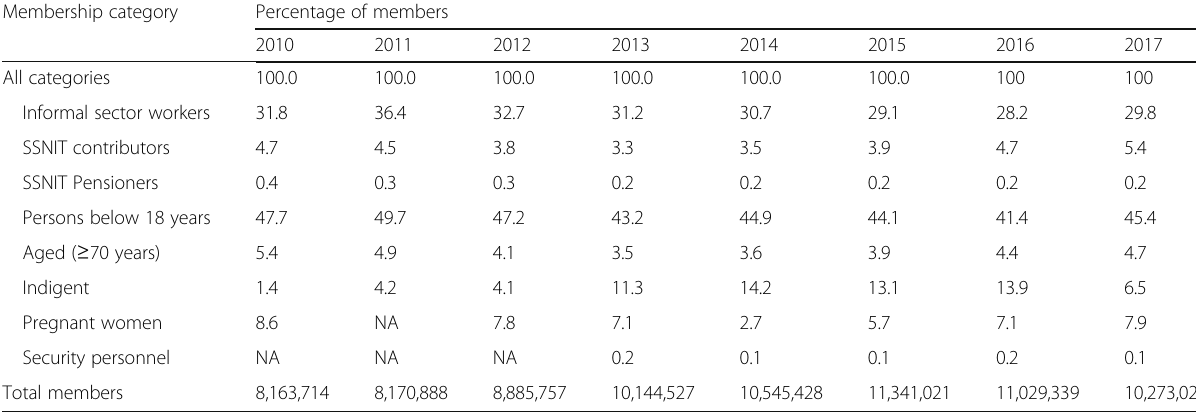
Table 1 Percentage distribution of members by category, 2010 –